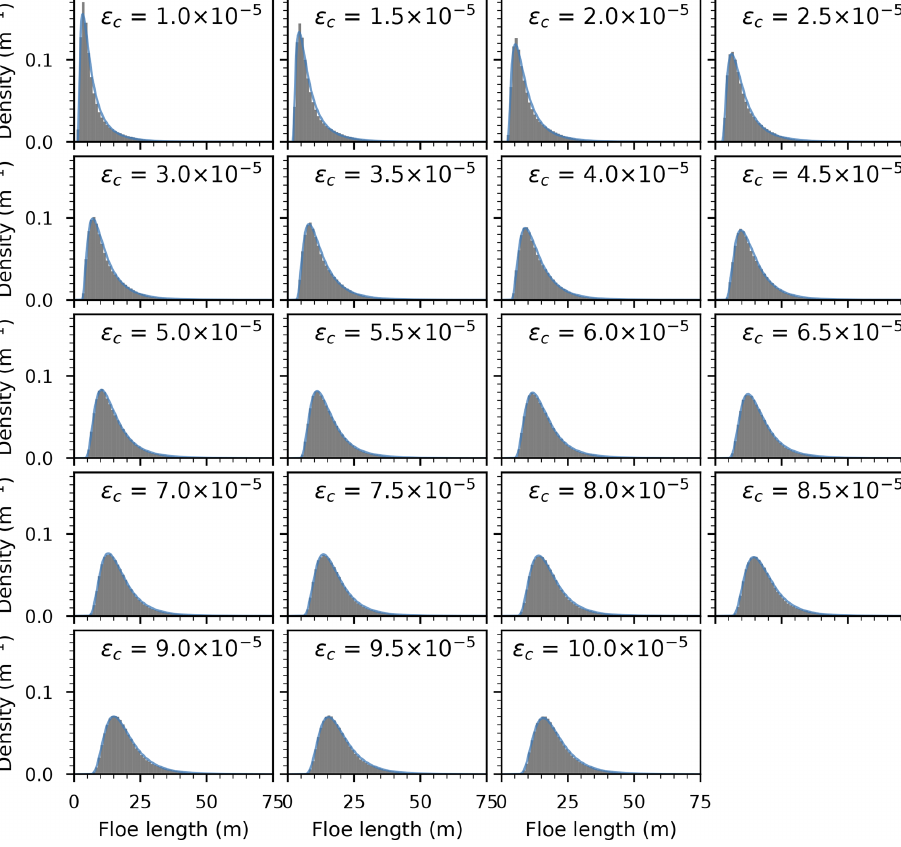
Figure C3. Histograms and average lognormal fits, as described in Sect. 5.2, for varying strain